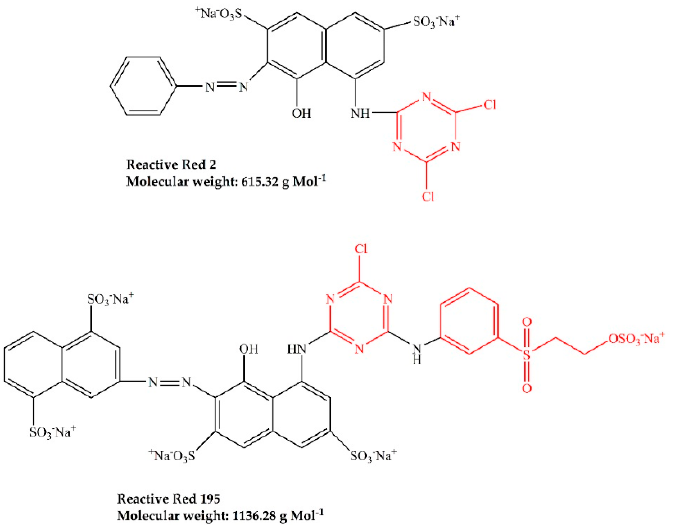
Figure 1. Chemical structures and molecular weights of Reactive Red 2 and Reactive Red 195.